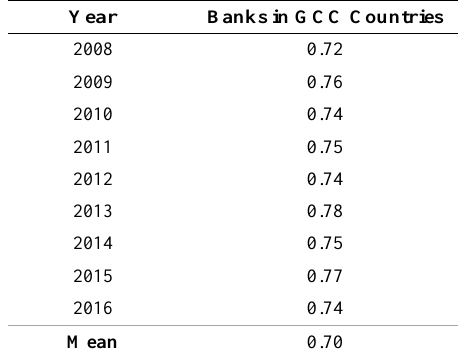
Table 3. Summary of banking average efficiency for